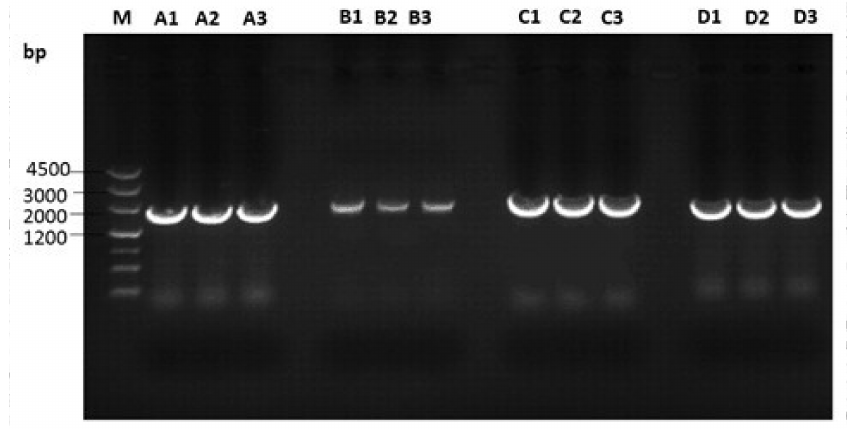
Figure 2. PCR amplification of the complete genomes of 3 isolates. M: DNA marker 3; 1–3: GD150509, GD160403, and GD160607; A, B, C, D: 4 DNA fragments of the complete genome.